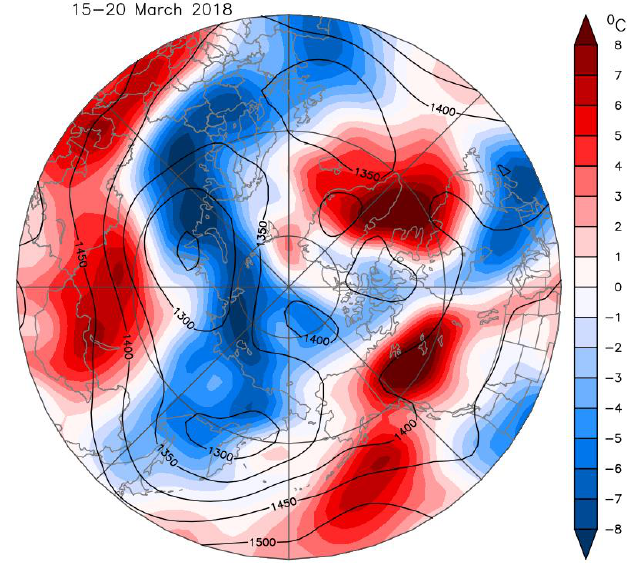
Figure 6. Helsinki daily mean and minimum temperature for early 2018 relative to the climatology averaged over 1981–2010. Data from Finnish Meteorological Institute.